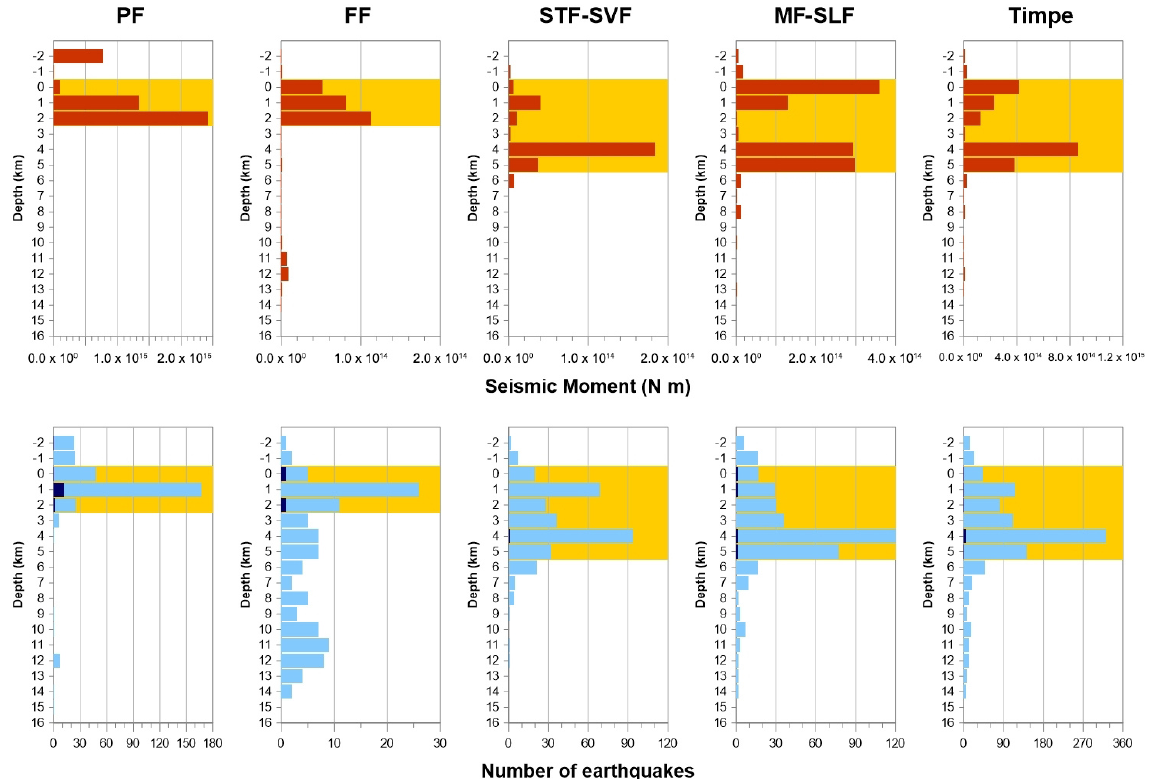
Figure 5. Distributions of seismic strain release (top panels) and number of earthquakes (bottom panels) vs. focal depth for the SZs considered in the model. Dark blue histograms indicate the number of earthquakes with M w ≥ 3.0. The effective depth is marked in orange. Abbreviations as in Fig.